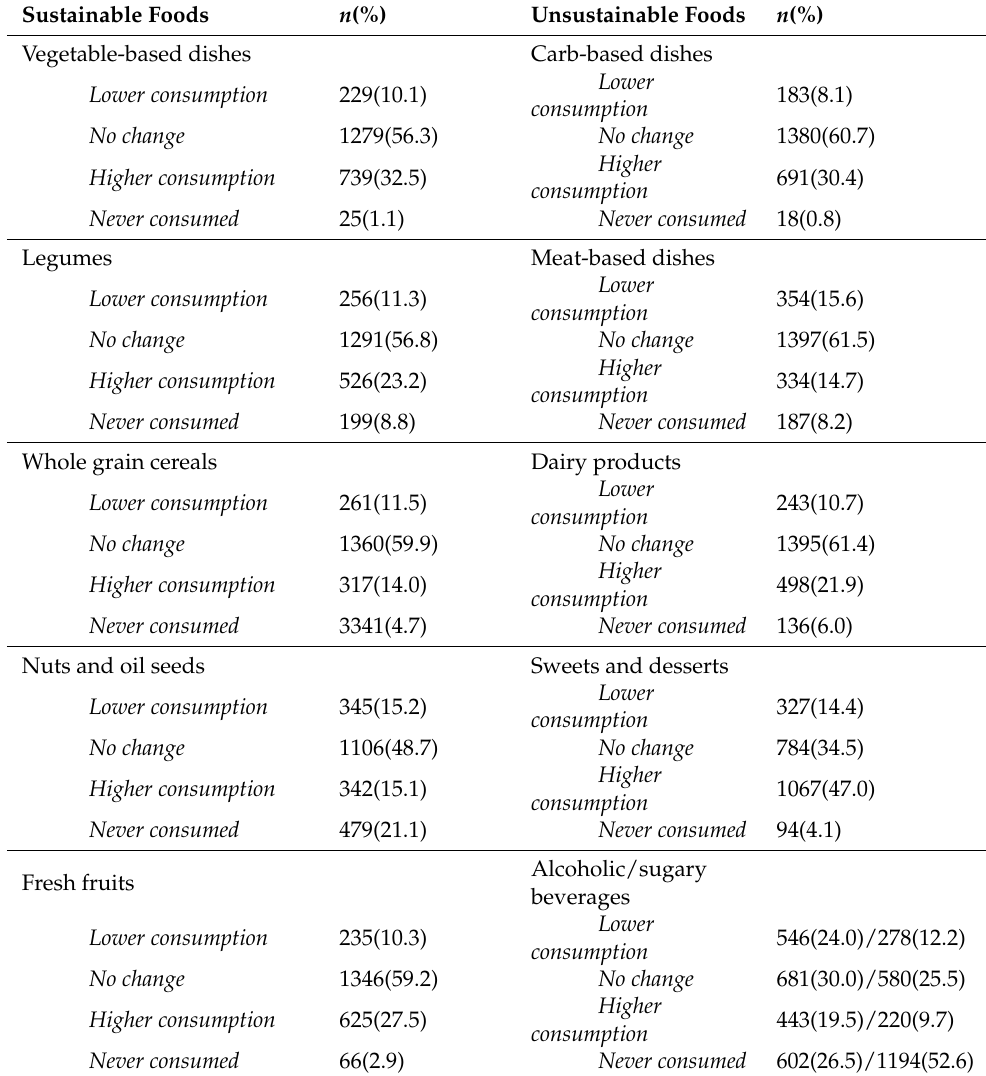
Table 2. Distribution of dietary habits of the study sample within sustainable and unsustainable food groups.